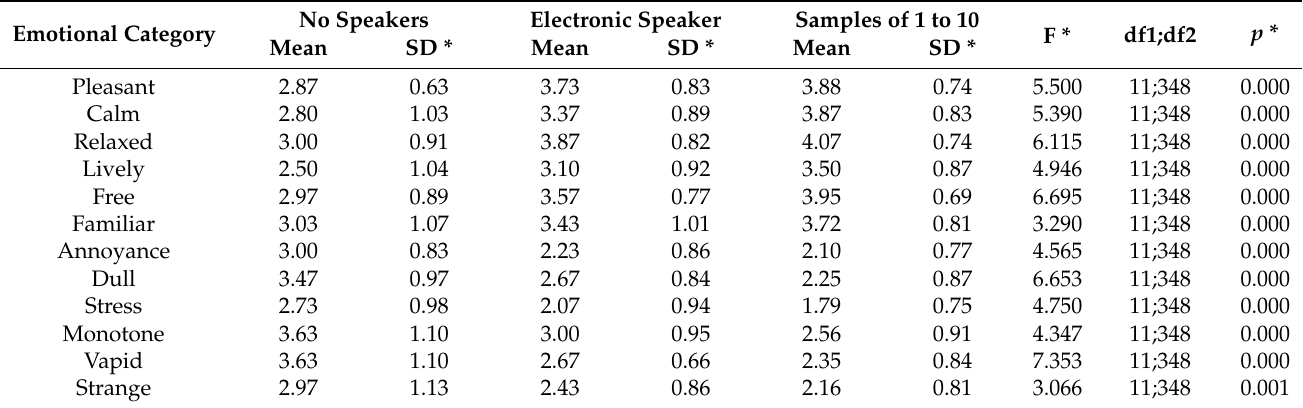
Table 10. Differences between 12 emotional perceptions under different sound conditions (white noise).